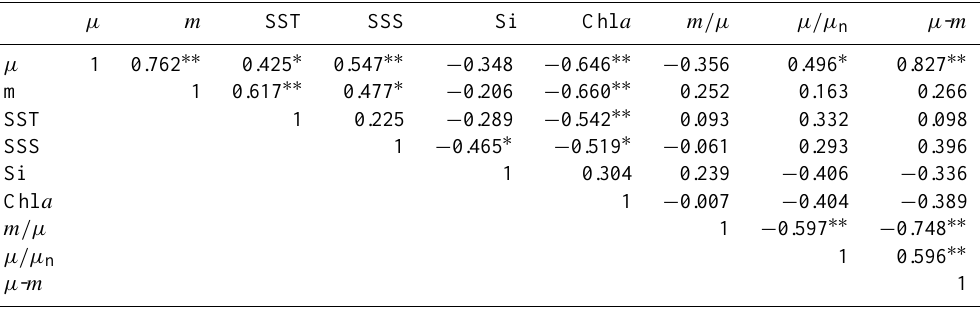
Table 4. Pearson correlation analyses between dilution experimental parameters and environmental variables. µ , phytoplankton growth rates without nutrient amendment; µ n , phytoplankton growth rates with nutrient amendment; m , microzooplankton grazing rates; SST, surface seawater temperature; SSS, surface seawater salinity; Si, silicate; Chl a , chlorophyll a .